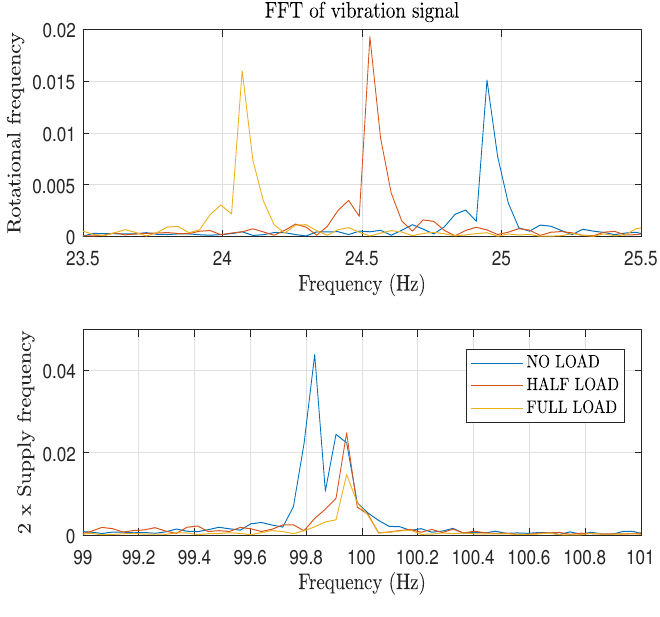
Figure 3. FFT of vibration